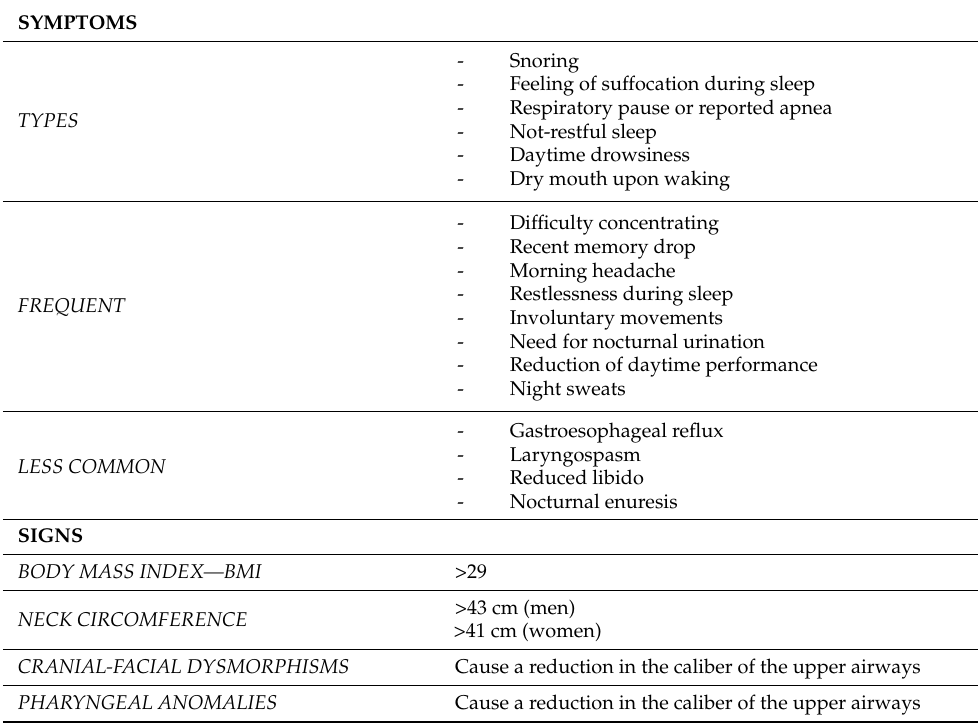
Table 1. Main symptoms and signs of OSA